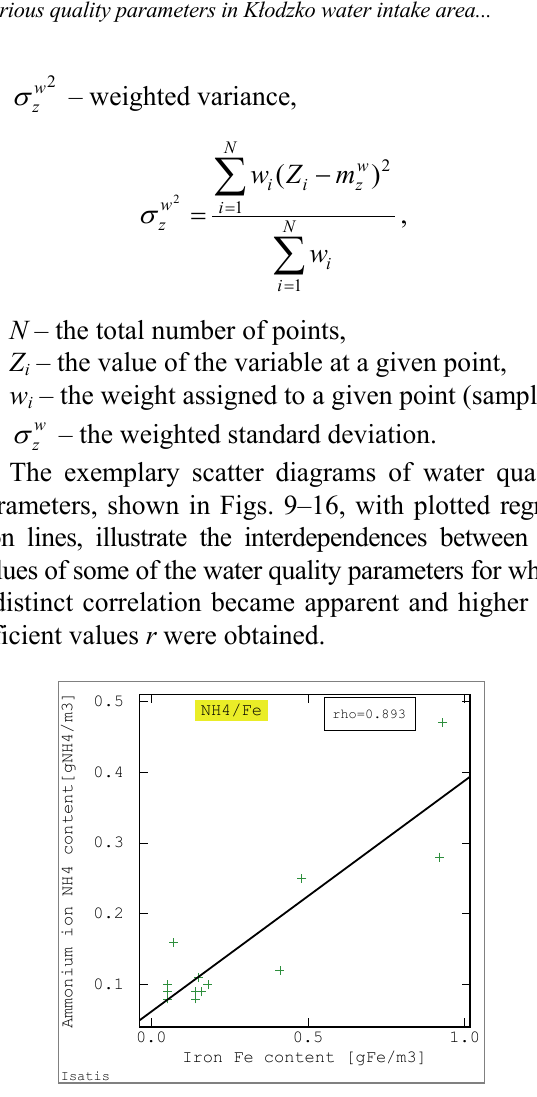
Fig. 9. Diagram correlation of Fe ++ iron content [g Fe ++ /m 3 ] and  NH ammonium ion content [g  NH /m 3 ] in underground water, 4 4 with the marked regression line Y / X in the area of water intake in the region of Kłodzko (14 wells)